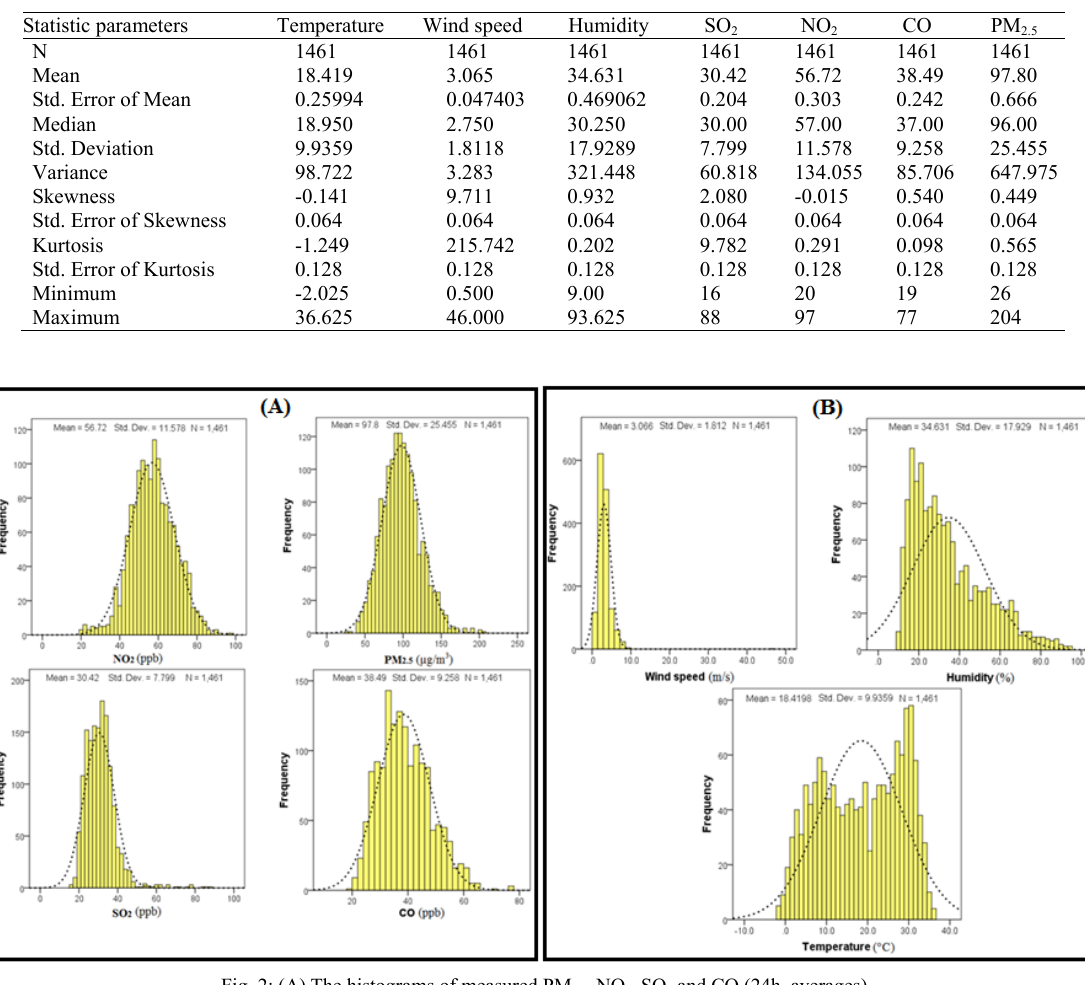
, NO , SO and CO (24h. averages). 2.5 2 2